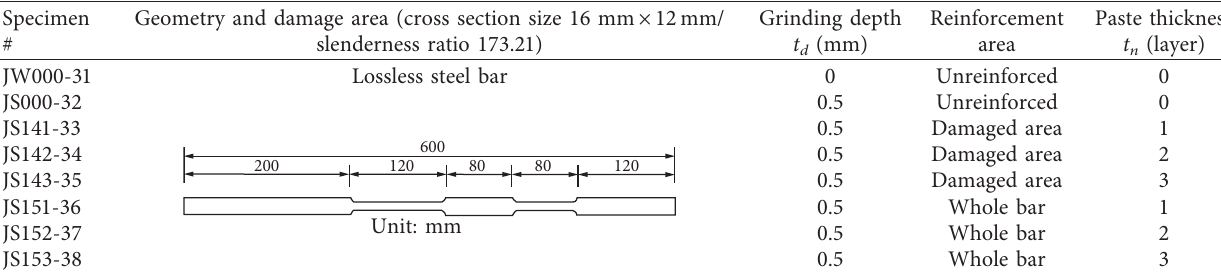
Table 3: Damage and reinforcement of steel specimens in Group 3.